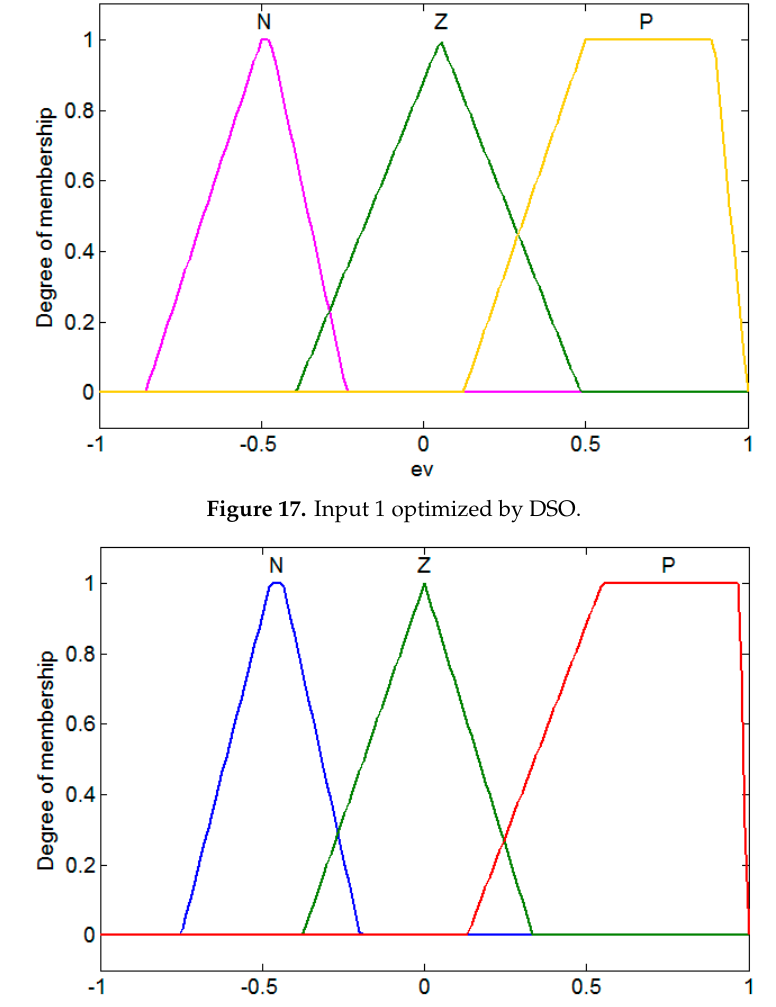
Figure 18. Input 2 optimized by DSO.